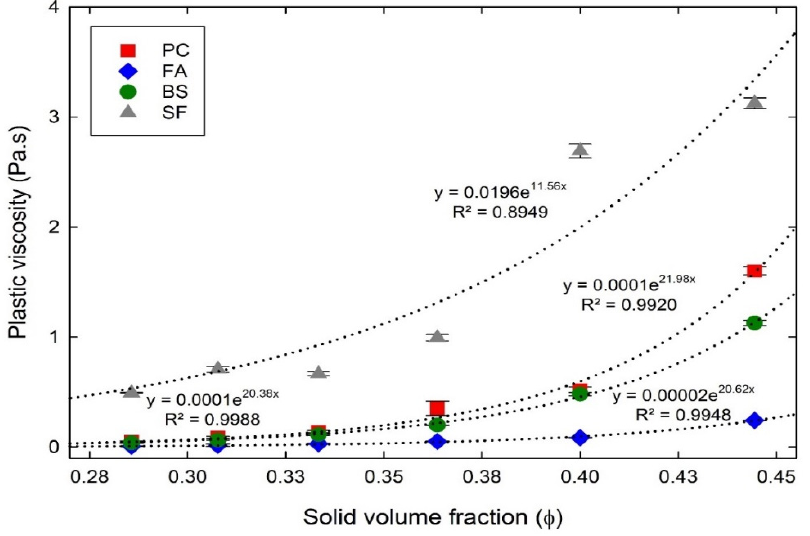
Figure 7. Plastic viscosity of cementitious suspensions with different 𝜙 in the